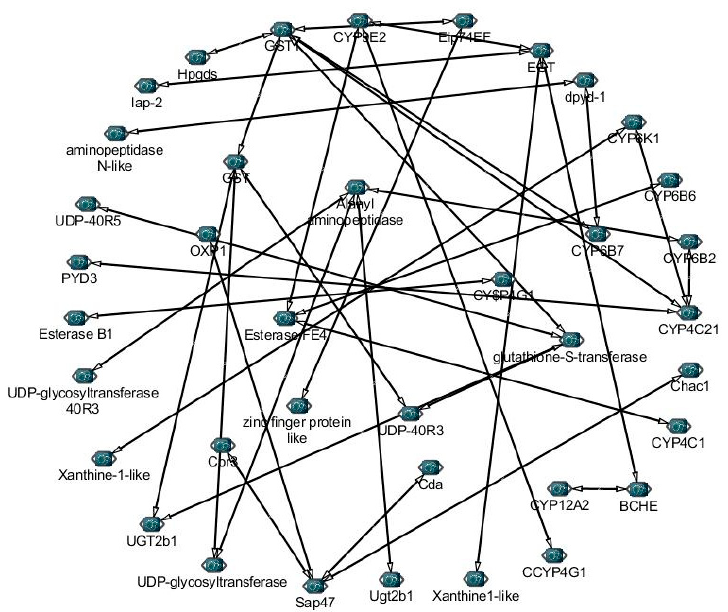
Figure 5. The correlation networks of 52 detoxification genes from different families involved in pathways under Noposion Yihaogong ® 5% EC insecticide stress treatment were established based on the Pearson correlation coefficients of these gene pairs using RNA-Seq data. The PCC of co-relation gene pairs was considered significant ( p < 0.05). Insects 2021 , 11 , x